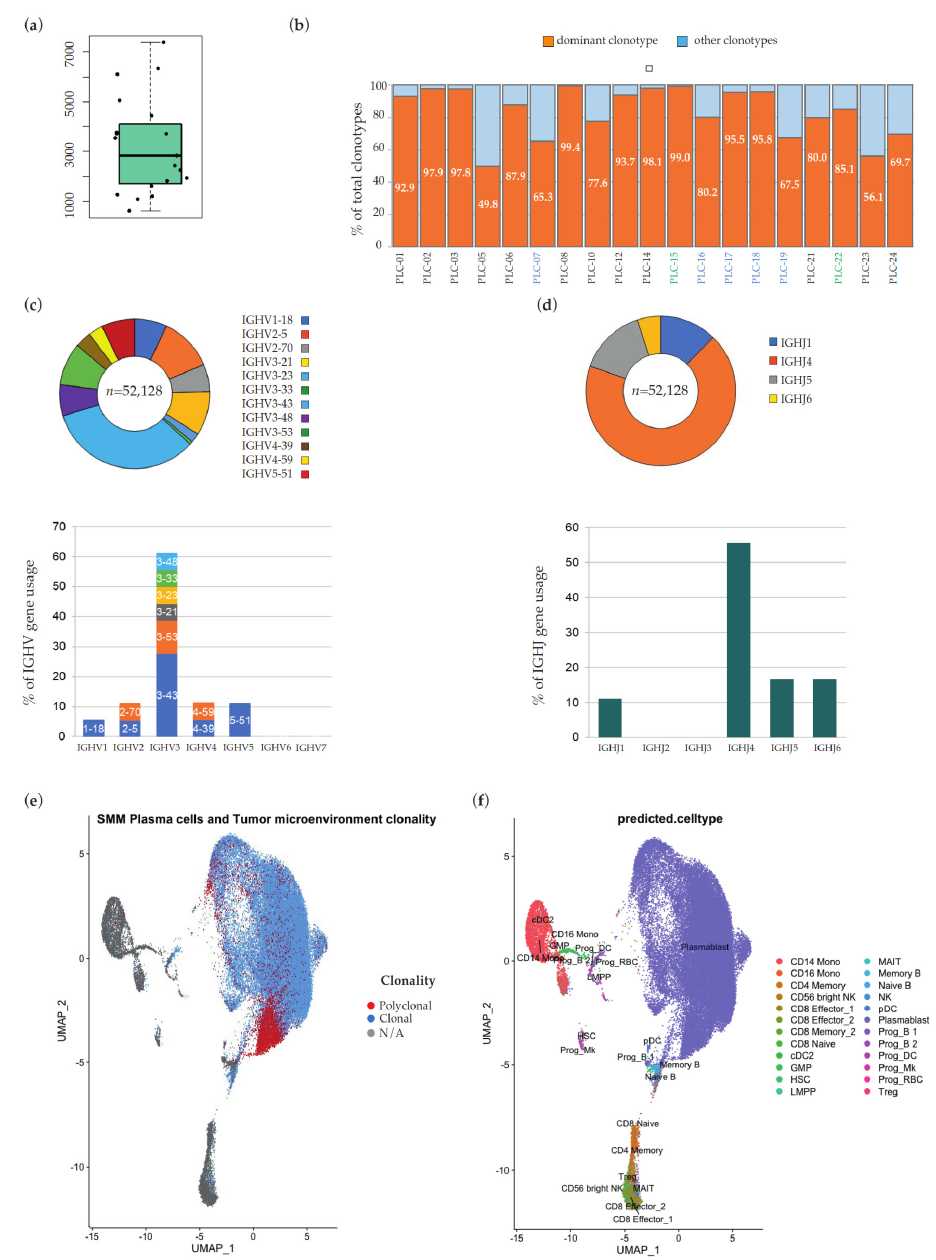
Figure 1. ( a ) Distribution of the number of barcodes estimated to be associated with cells that express targeted V(D)J transcripts in the 19 patients’ samples. ( b ) Percentage of barcodes associated with the dominant clonotype and with all other clonotypes, respectively, in the 19 patients’ samples. On the x -axis, IDs of MGUS samples are in blue, IDs of SMM samples are in black and IDs of MM samples are in green. VH ( c ) and JH ( d ) gene usage in 18/19 MM samples with clonal heavy chain rearrangements. The histograms show the sample-level rate of use of each IgH variable region gene family on total of clonal rearrangements. Within each V-family, discrete bands represent each of the individual genes, as indicated. Above each histogram, the representativeness of relative IGH genes/families is plotted at single-cell-level, as number of associated cellular barcodes. ( e , f ) UMAP dimension reduction of all the barcodes sequenced from samples obtained after CD138-based magnetic beads positive selection. In ( e ), light blue dots represent barcodes associated with the dominant clonotype of each sample, red dots barcodes associated with other rearrangements, and grey dots barcodes with unrearranged Ig heavy and light chain loci. In ( f ), dots are color-coded according to transcriptome-based cell type assignment, as indicated in the legend.